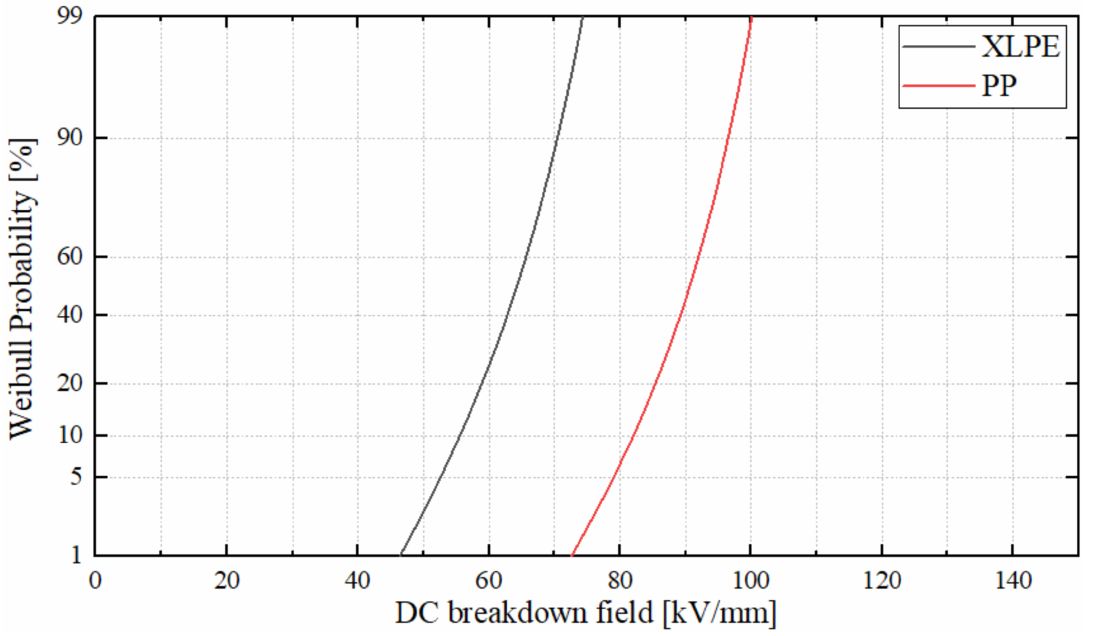
Figure 2. Weibull probability vs. DC breakdown field of the calibrated